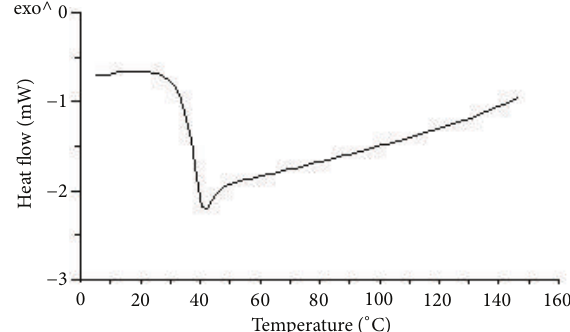
Figure 5: Typical DSC curve of ET-10 composite showing glass transition